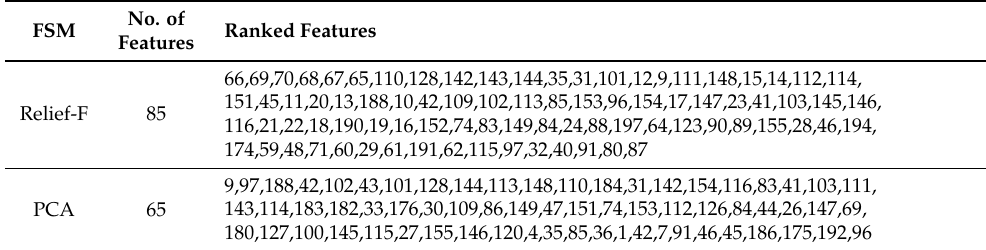
the PCA feature selection method. The feature numbers listed in this table correspond to the numbering used in Table 4. Table A1. Features ranked in descending order per feature selection